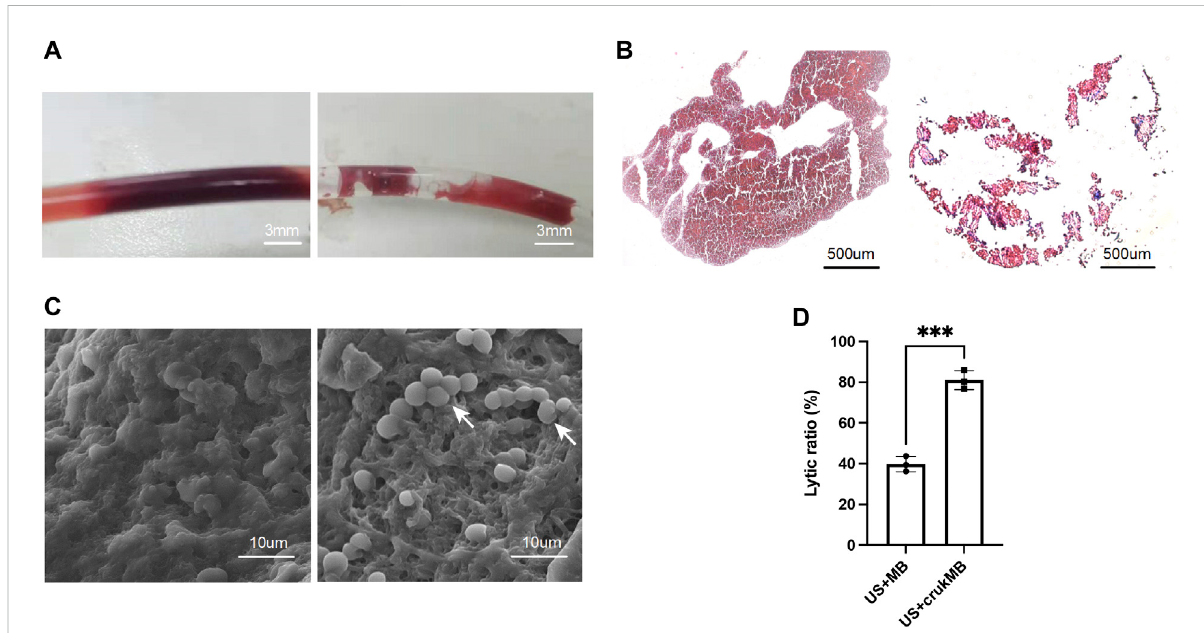
FIGURE 3 Enhanced sonothrombolysis with crukMBs in vitro . Blood clot images of macroscopy (A) , scale bars, 3 mm, bright fi eld microscopy (B) , scale bars, 500 µm and SEM (C) , scale bars, 10 µm before and after LFUS + crukMB sonothrombolysis. White arrows indicate the exposed